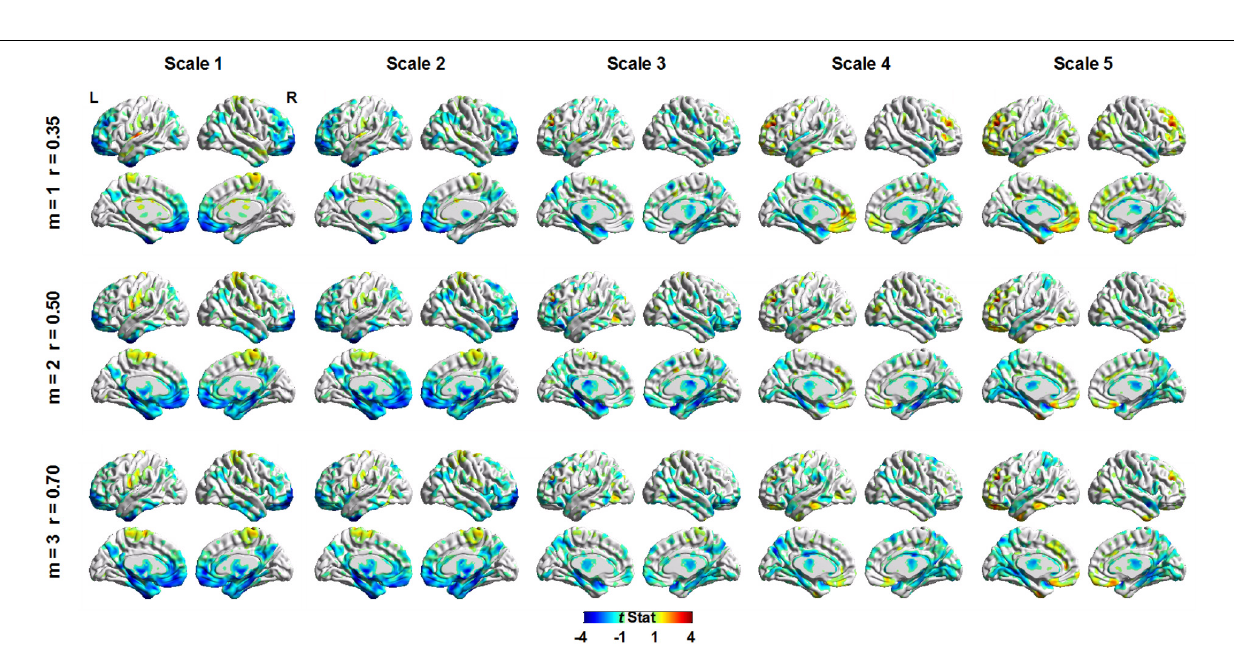
Frontiers in Neuroscience |